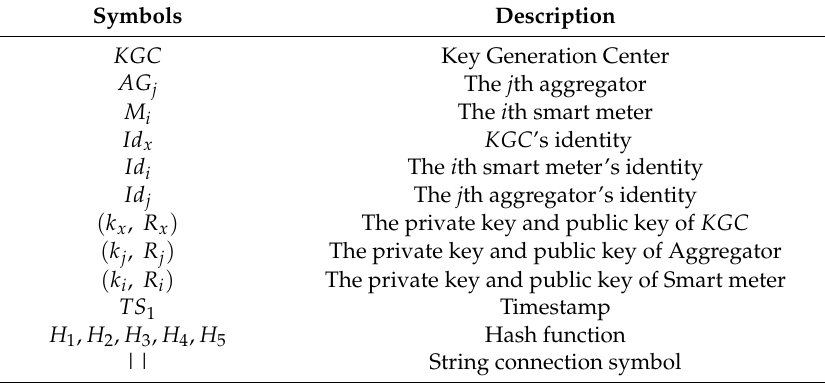
Table 8. Request and authentication phase of the proposed